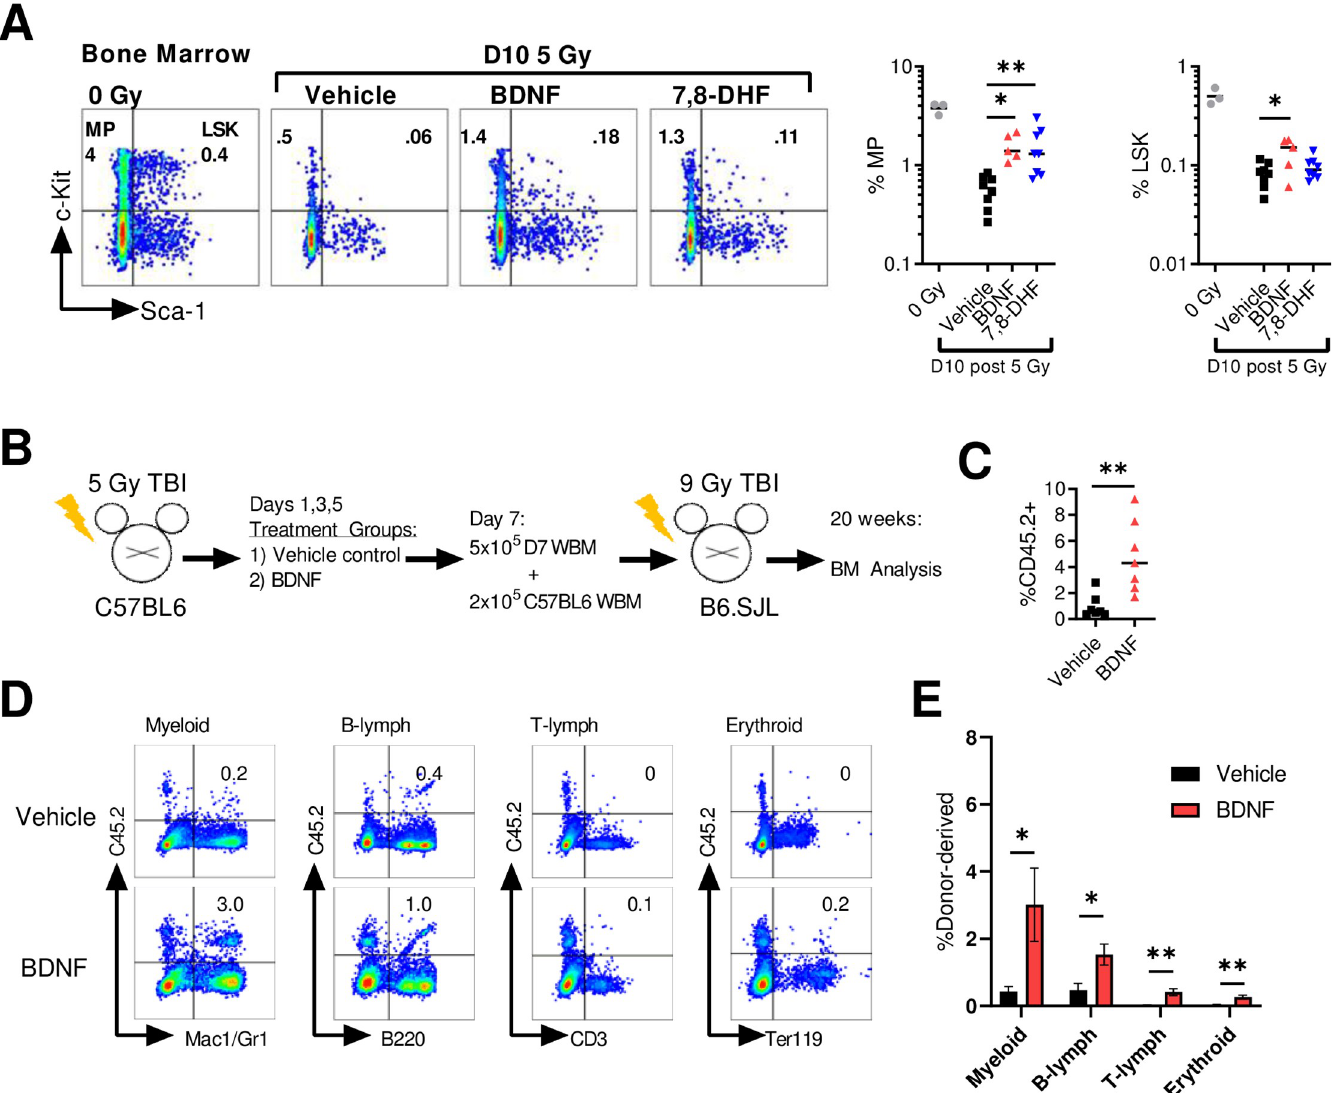
Fig 4. BDNF administration increases bone marrow stem and progenitor cell recovery following TBI. (A) Left, representative day 10 bone marrow FACS analysis of lin-c-kit+ myeloid progenitors (MP) and lin-sca-1+c-kit+ (LSK) cells. Right, %MP and %LSK of the total viable bone marrow cells. (B) Schematic representation of the experimental design: adult C57BL/6 mice were irradiated with 5 Gy and treated starting at 24 hours with vehicle, 0.5 mg/kg BDNF. At day 7, bone marrow was harvested and transplanted competitively into congenic recipient B6.SJL mice. (C) Total bone marrow engraftment at week 20 post-transplant. (D) Representative FACS analysis of bone marrow myeloid, B-lymph, T-lymph, and erythroid engraftment at 20 weeks post-transplant. E, %Donor-derived myeloid, B-lymph, T-lymph, and erythroid engraftment at 20 weeks post-transplant. (n = 7 recipient mice per group). Shown are mean values +/- SEM. � P < .05, �� P < .01.